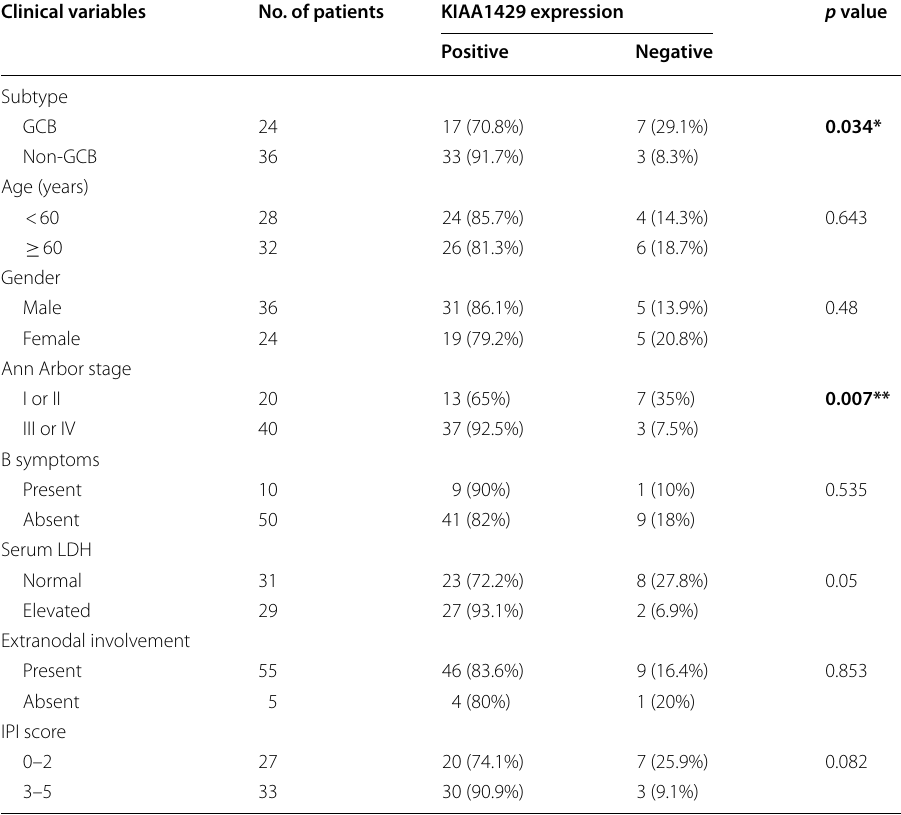
The bold values mean statistically significant GCB germinal center B cell-like, LDH lactate dehydrogenase, IPI International Prognostic Index * p < 0.05, ** p <